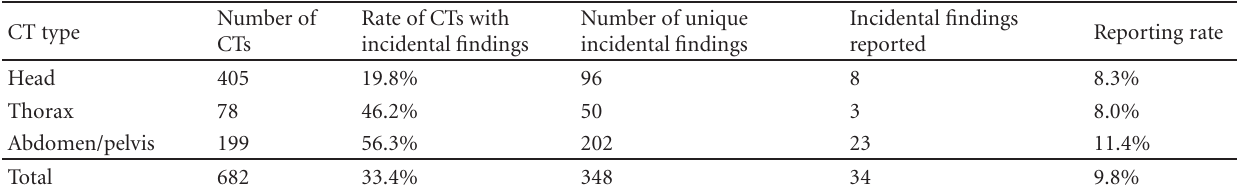
Table 1: Incidental findings and reporting rates by CT type.